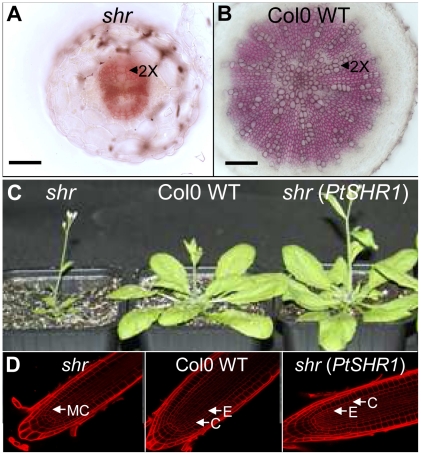
Morphology of shr, Col0 wild-type (WT) and promAtSHR:PtSHR1 complemented shr null mutant.Transverse sections of Arabidopsis shr mutant hypocotyls at 32 DAS; (A) Col0 WT Arabidopsis hypocotyls at 32 DAS; (B) Shoot phenotype of homozygous shr mutant, Col0 WT and homozygous shr mutant expressing the PtSHR1 coding sequence driven by 2.5 kb of the AtSHR promoter sequence; (C) Root tips of lines in (C); Hypocotyl sections stained with phloroglucinol to reveal lignified cells. Scale bar is 100 µm. Root tip cell walls stained with propidium iodide. 2×, secondary xylem; MC, mutant cell layer (shr lacks normal endodermal cell layer); C, cortex; E, endodermis.